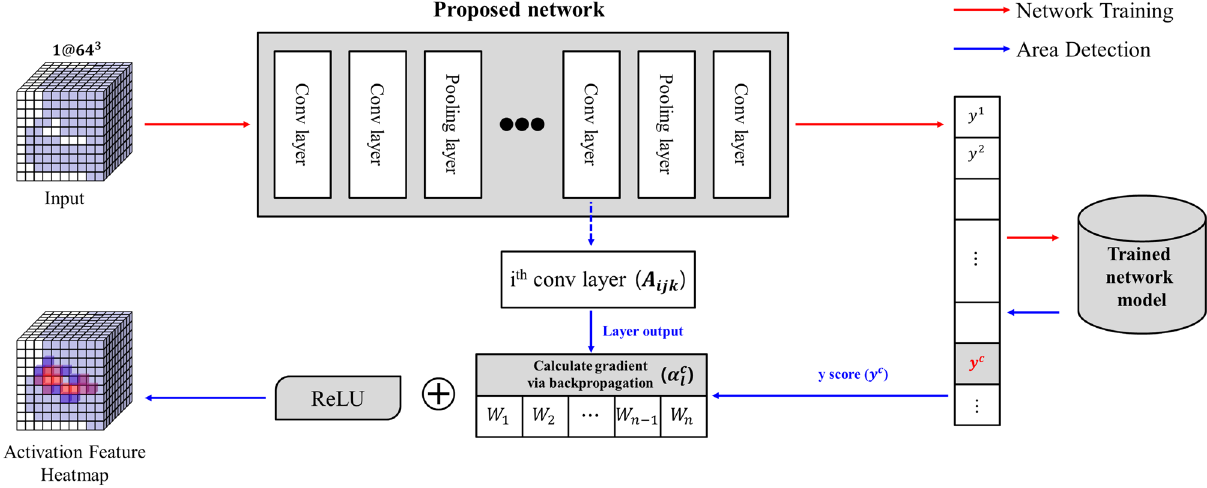
Figure 4. Feature area detection using